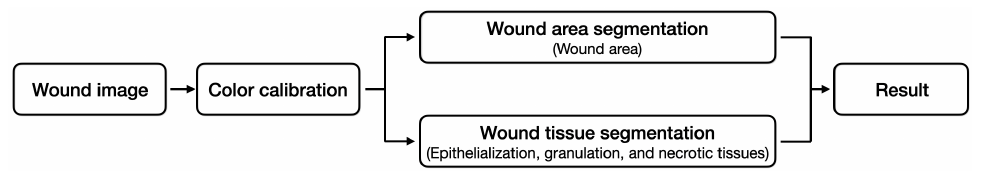
Figure 4. Wound assessment